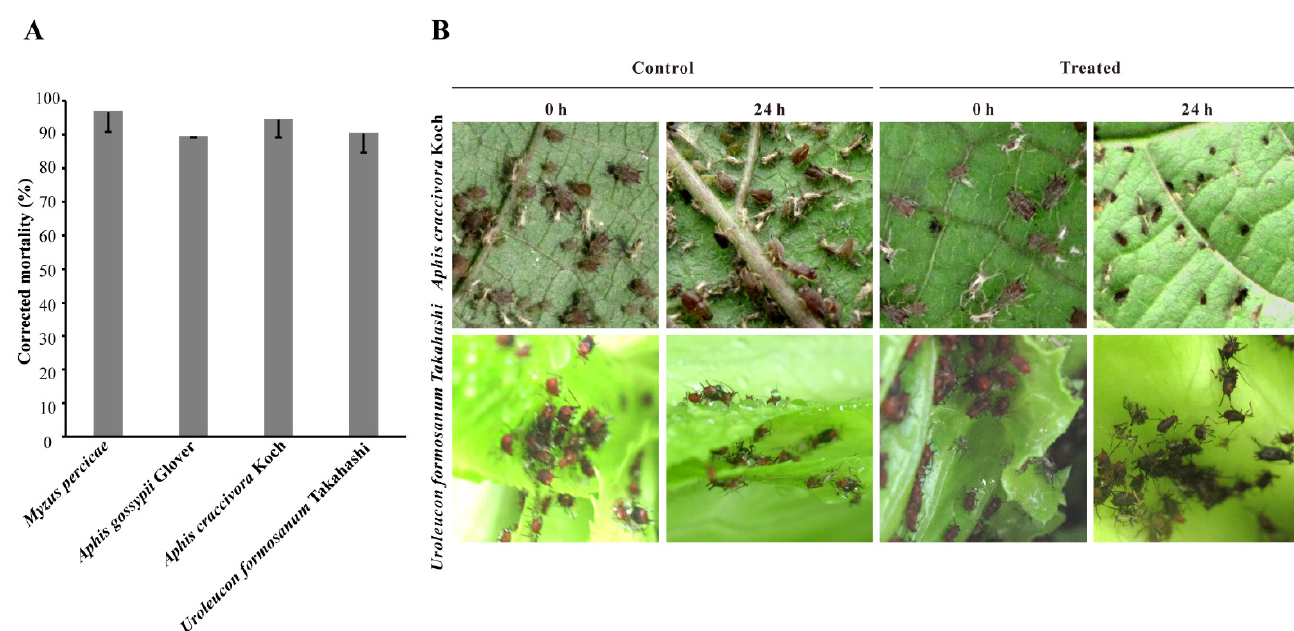
Figure 4. Insecticidal activity of the fermentation supernatant from B. velezensis ATR2. ( A ), Aphicidal activity of the fermentation supernatant diluent (10% dilution) against the tested aphids in laboratory bioassays. ( B ), Aphicidal activity of the fermentation supernatant against Aphis craccivora Koch and Uroleucon formosanum Takahashi in the field. Means and standard deviations were statistically calculated using the software package SPSS